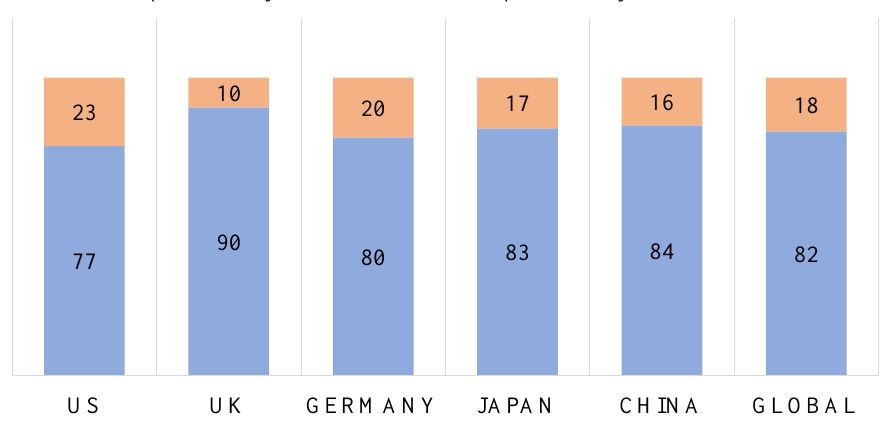
Figure 6. Irdeto 2019 survey results.